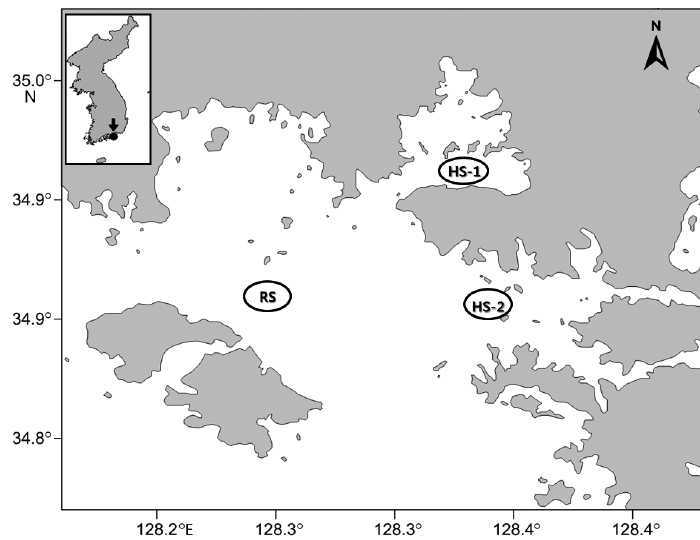
Fig. 1. Location of the study sites at the southern Korean coast. Two hypoxic sites (HS) in highly sheltered bays (HS-1 in Goseong Bay, HS-2 in Buksin Bay) and 1 normoxic reference site (RS) in a nearby